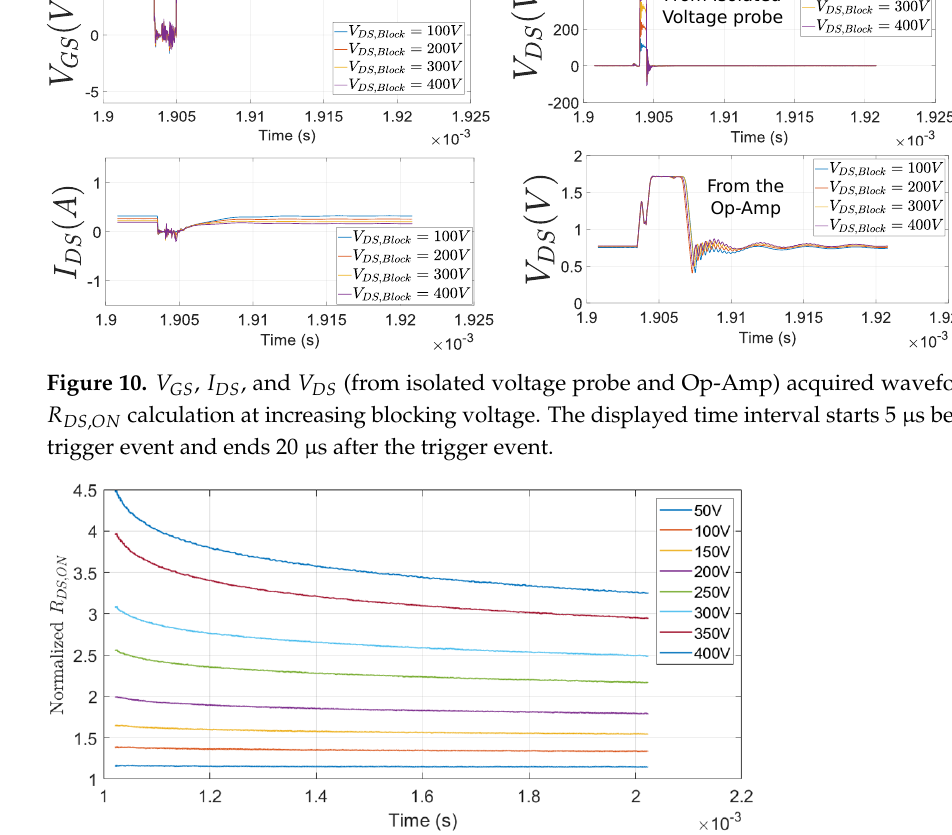
Figure 11. Normalized R DS , ON of a single sample measured over the entire